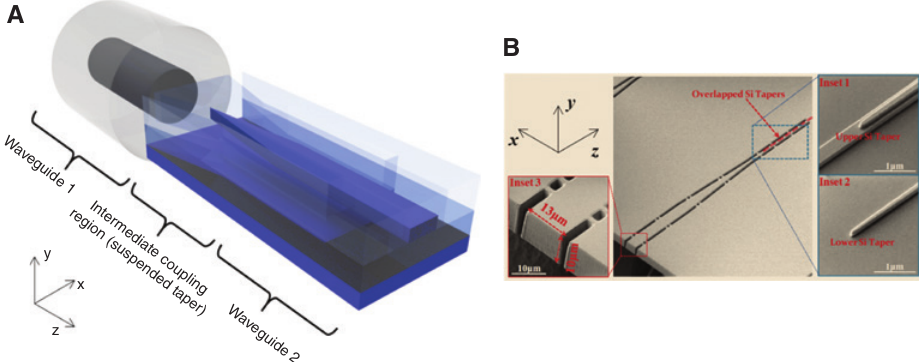
Figure 5: (A) Schematic diagram of a suspended intermediate waveguide structure. (B) An example of an inversely tapered silicon waveguide surrounded by a SiO cladding with a cantilever structure. The SEM images of the fabricated couplers are shown. 2 Adapted from Ref. [65]. Copyright (2011) The Optical Society.